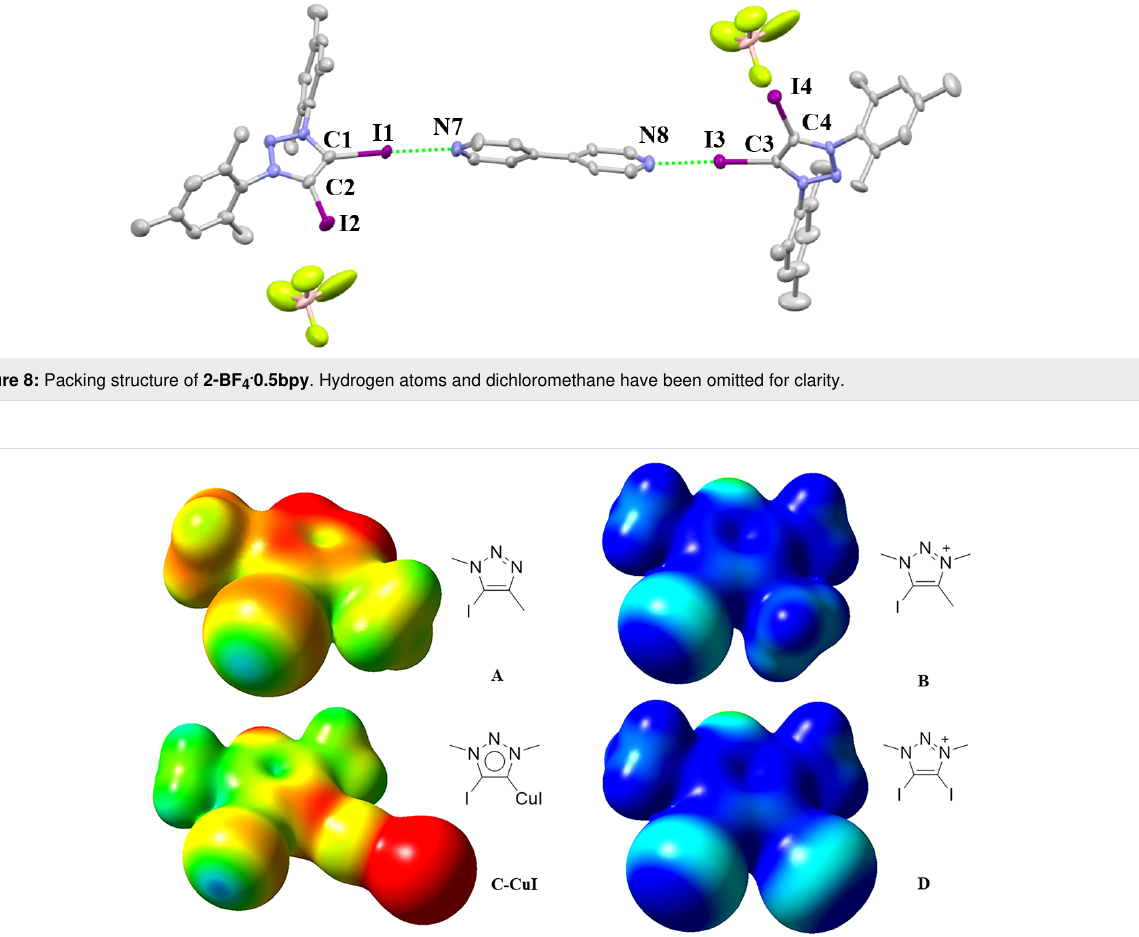
Figure 9: 1,2,3-Triazole-based halogen model calculation: electrostatic potential surfaces mapped on total density (iso value 0.01). C was calculated using 1,2,3-triazolylidene copper iodide complex C-CuI .